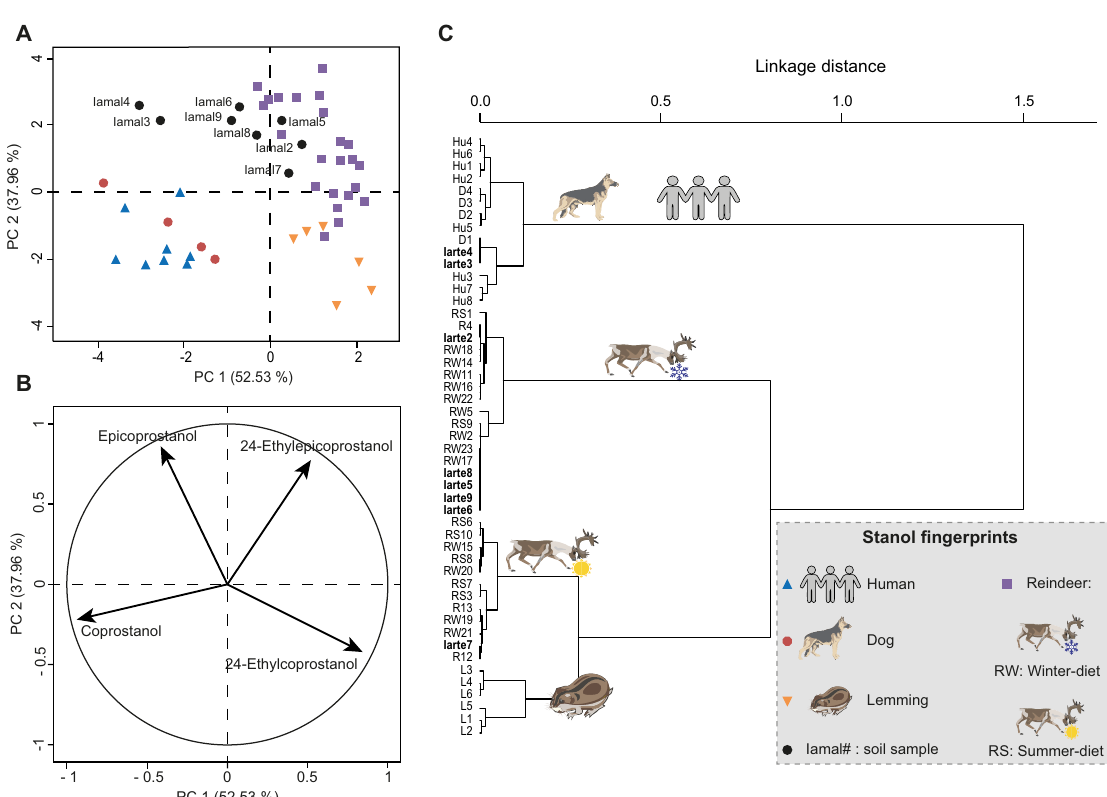
Fig 8. Multivariate analyses to identify the faecal fingerprints of soil samples from the I ͡ Amal peninsula site based on only the four compounds commonly used in the literature: coprostanol, epicoprostanol, 24-ethylcoprostanol and 24-ethylepicoprostanol. PCA and HCPC of the four main 5 β -stanol distribution (arcsine-root transformed) of reference faecal material from dog (D), human (Hu), lemming (L) and reindeer (R) and soil samples. Reference and soil sample nomenclature can be found in S2 Table. ( A ) PCA score plot of PC1 and PC2. The high variance explained by the first two PCs is due to the low number of variables (four). ( B ) PCA correlation circle of PC1 and PC2. ( C ) Dendrogram obtained by HCPC calculated from the first two PCs of the PCA.